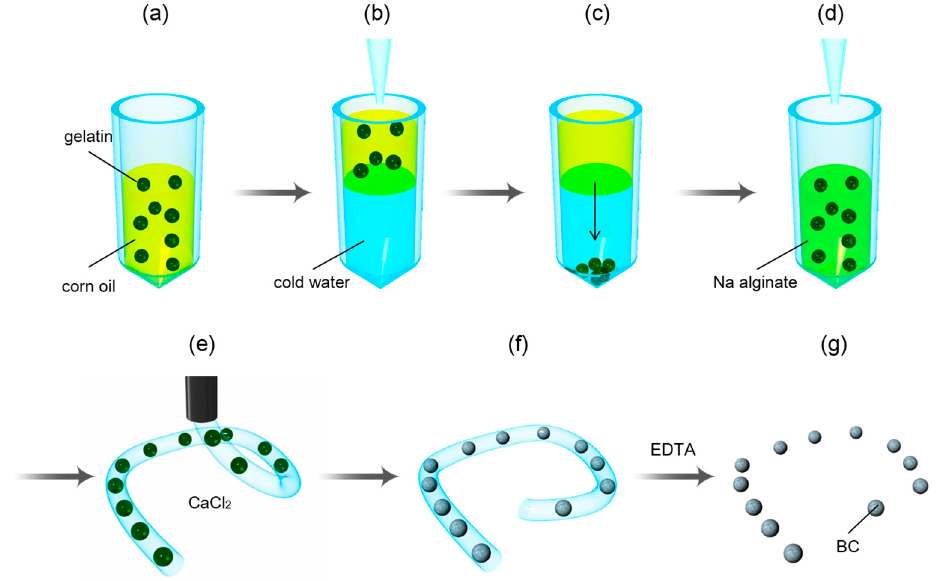
Figure 1. Process flow of the fabrication method: ( a ) Emulsion was cooled to solidify the gelatin containing bacterial cellulose (BC)-producing bacteria. ( b ) The prepared emulsion was placed onto cold water (~2 °C). ( c ) The gelatin gel microspheres in the emulsion were transferred into cold water by centrifugation. ( d ) The gelatin gel microspheres were dispersed in a solution of sodium alginate by changing the dispersion medium. ( e ) A calcium alginate gel fiber containing the gelatin microspheres was formed by casting the sodium alginate solution into calcium chloride solution with a syringe. ( f ) By transferring the formed fiber into the culture medium for the bacteria at 30 °C, the gelatin gel changed to sol state. Here, the bacteria produced BC in the calcium alginate gel fiber. After producing BC, the calcium alginate gel fiber was dissolved in a solution of ethylenediamine tetraacetic acid (EDTA). ( g ) BC microspheres were obtained through this process.